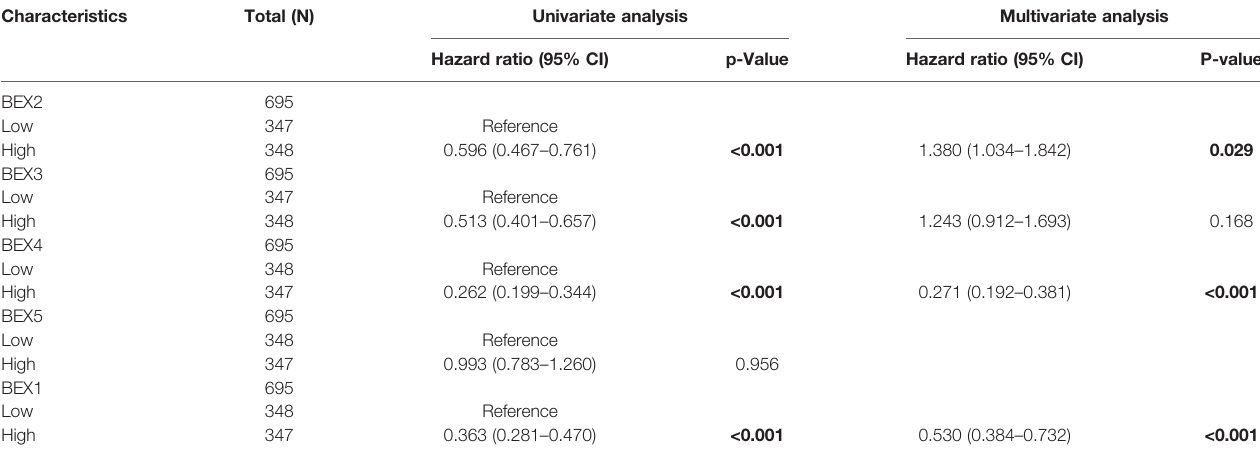
TABLE 1 | Univariate and multivariate Cox regression analyses of BEX family in GBM.